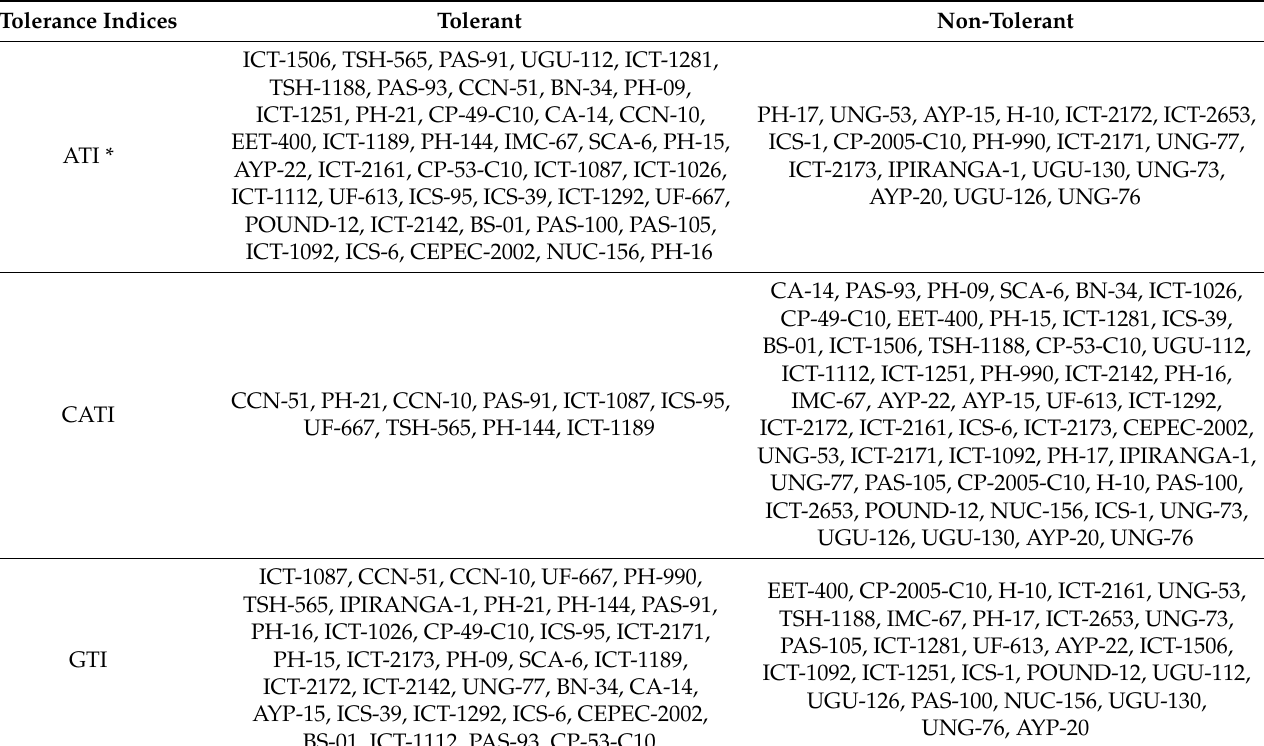
Table 5. Clones selected as tolerant, and non-tolerant (medium and sensitive) with the application of the ATI (acid tolerance index), CATI (corrected acid tolerance index), and GTI (genotypic tolerance index) for selecting cacao genotypes tolerant to soil